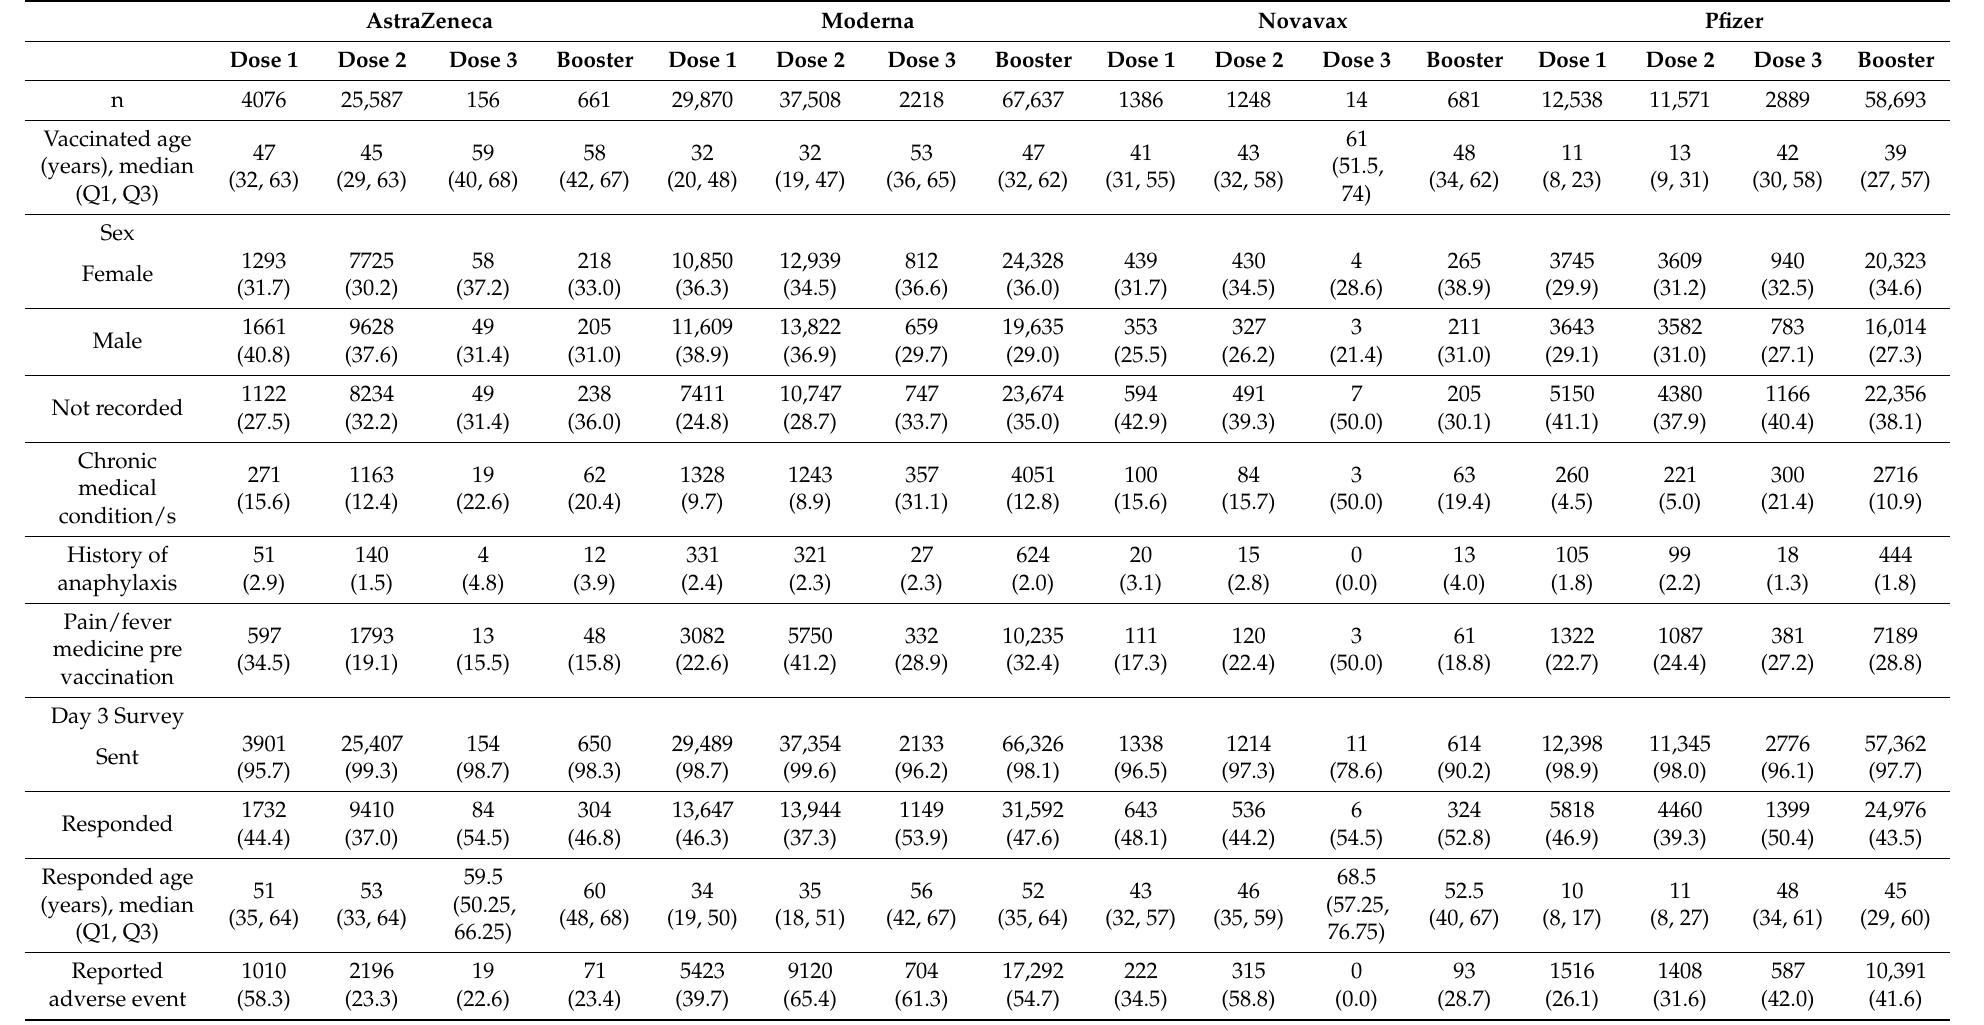
Table 1. Characteristics of COVID-19 vaccination encounters by vaccine brand and dose